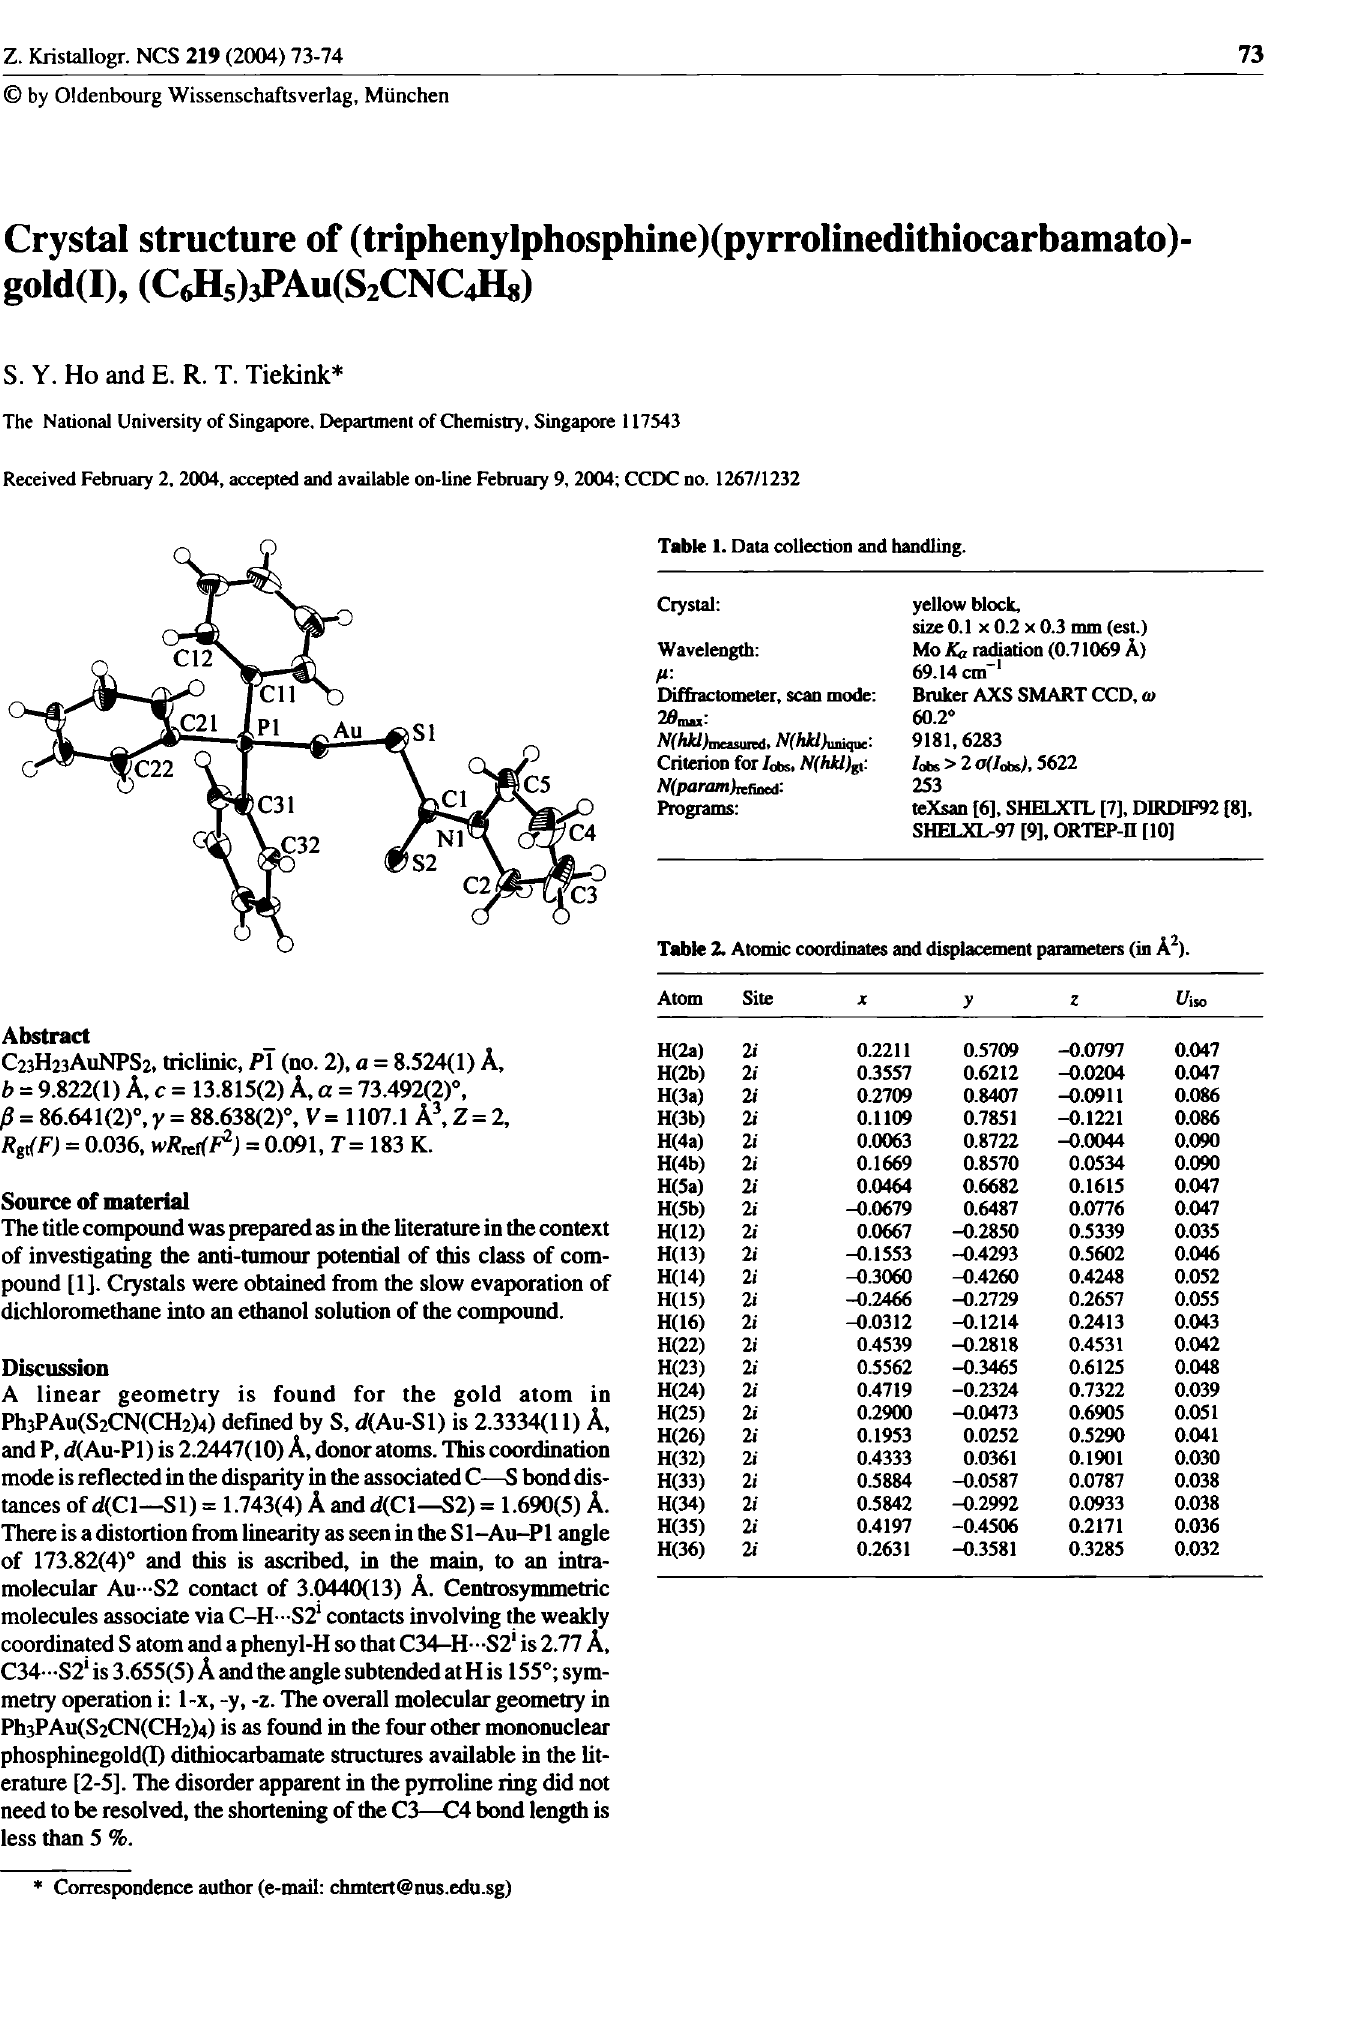
Table 1. Data collection and handling.